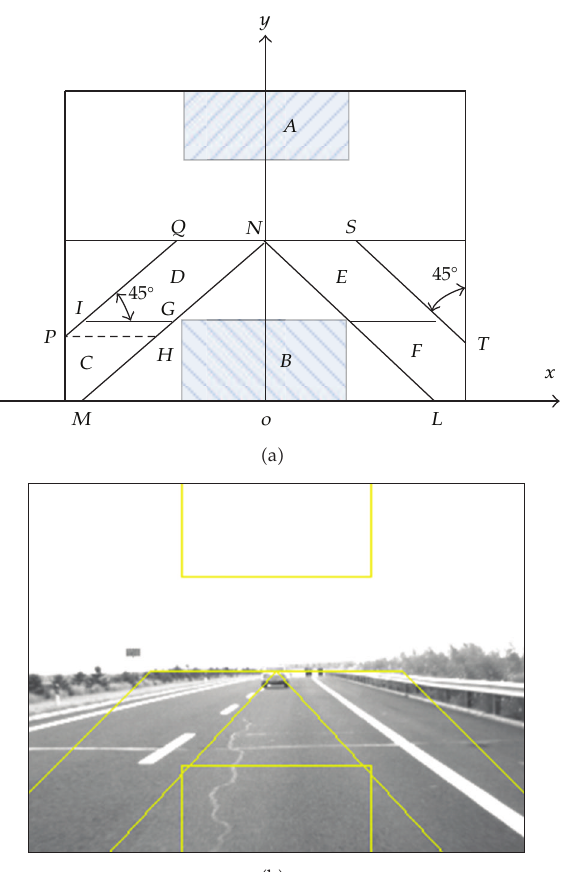
Figure 1: Schematic of feature regions division in detection